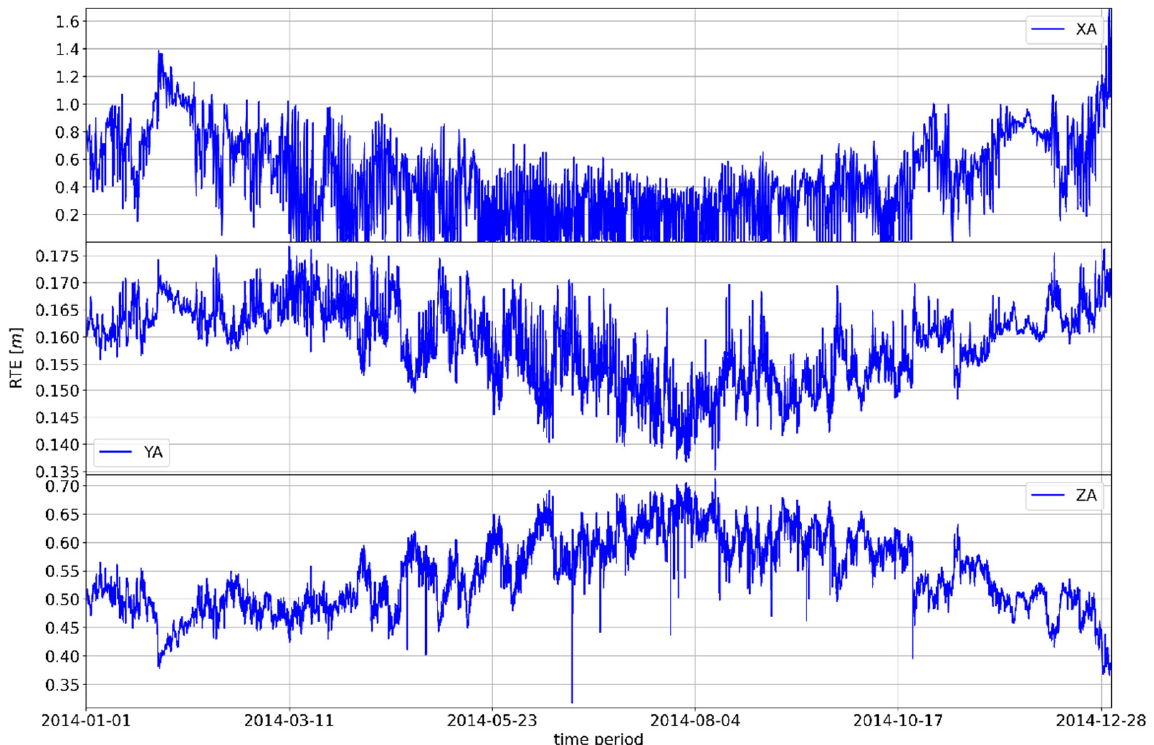
Figure 6. Movement of the absolute difference of the parameter RTE at the GNSS position Čakovec in 2014.